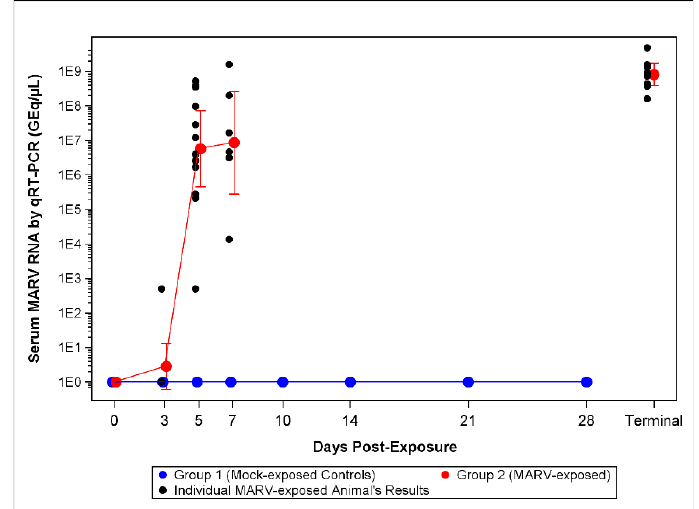
Figure 3. qRT-PCR Assay Serum MARV RNA Titers. The lower limit of quantitation (LLOQ) for the assay is 1.0 × 10 3 GEq/µL and the lower limit of detection LLOD is 0. For statistical analysis and graphing LLOQ samples were assigned 5 × 10 2 GEq/µL and LLOD samples were assigned 1.0 GEq/µL. Symbols represent geometric mean concentrations and bars indicate 95% confidence intervals. The confidence intervals on all Days 0 through 28 for mock-exposed control animals, and on Day 0 for MARV-exposed animals, were not plotted as the results were all below the limit of detection for the assay. Terminal draws in animals that met euthanasia criteria were plotted as a single time point.